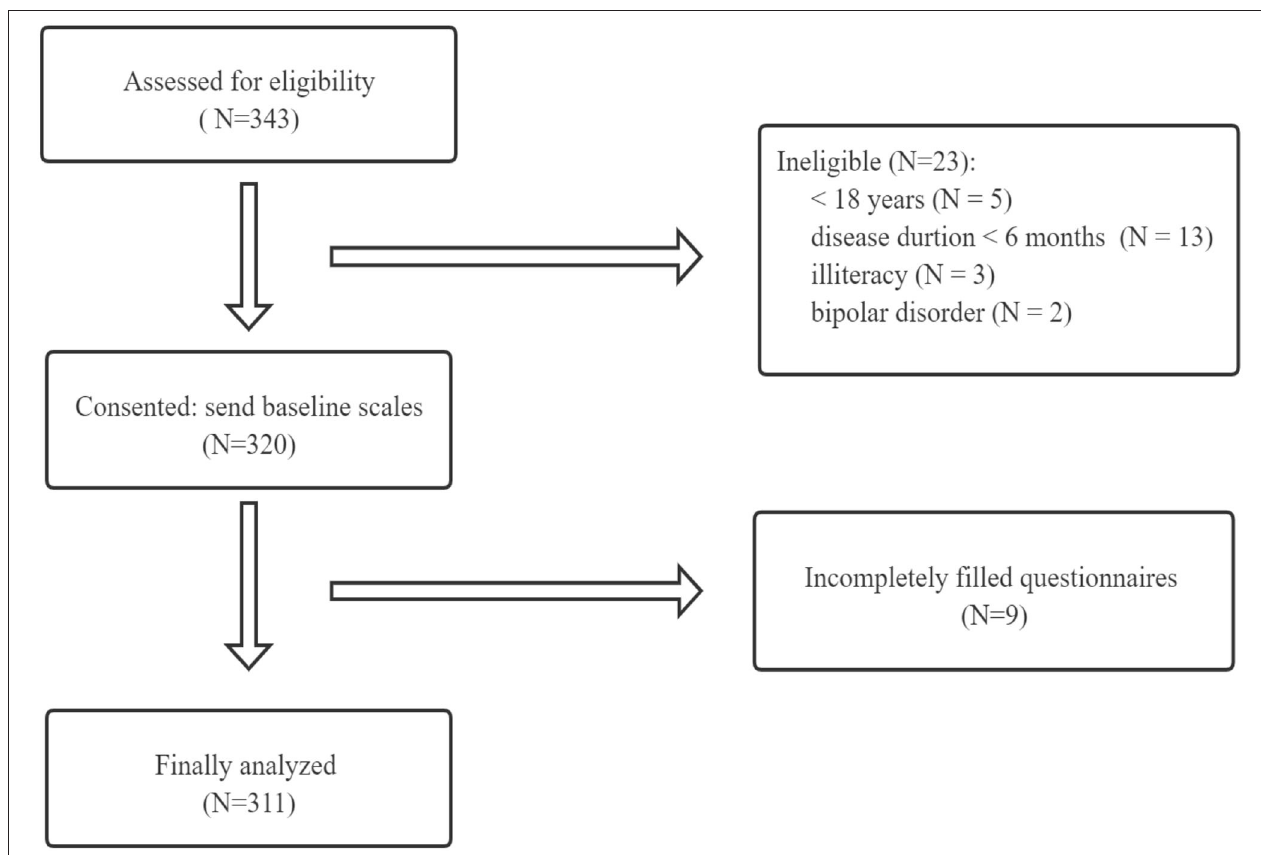
FIGURE 1 | Participant recruitment flow